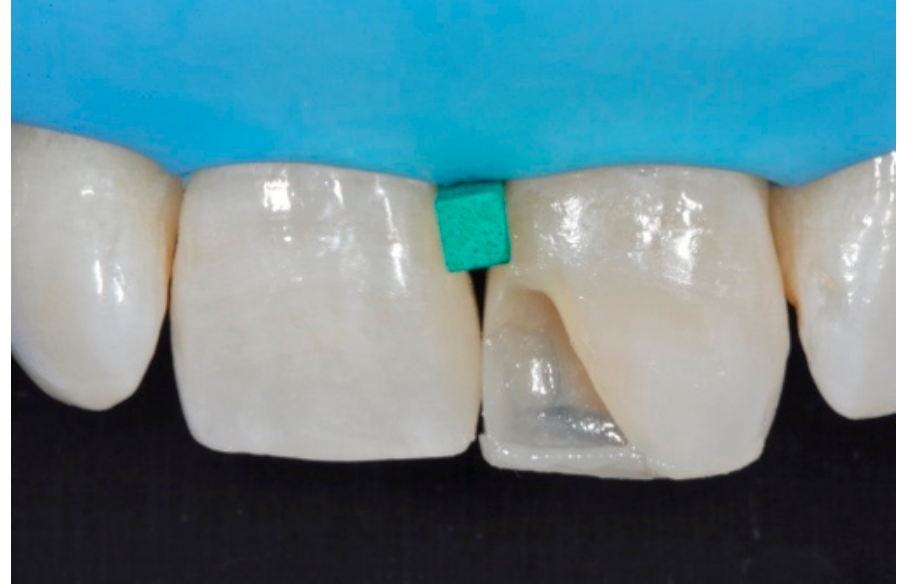
Figure 43. The frame completed.